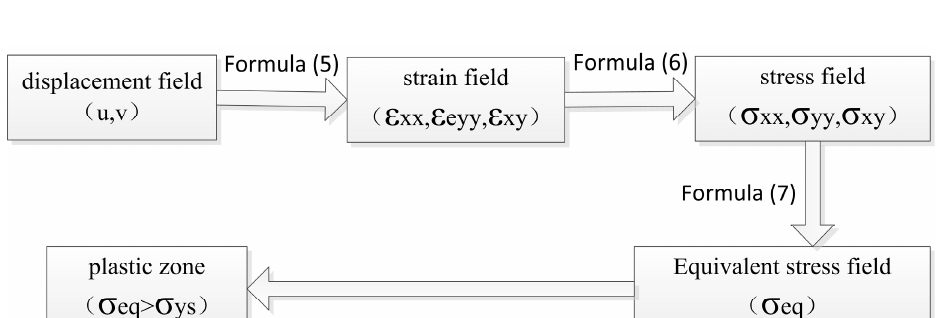
Figure 5. Flow chart showing how DIC was used to solve the stress field by the displacement field of the crack surface.